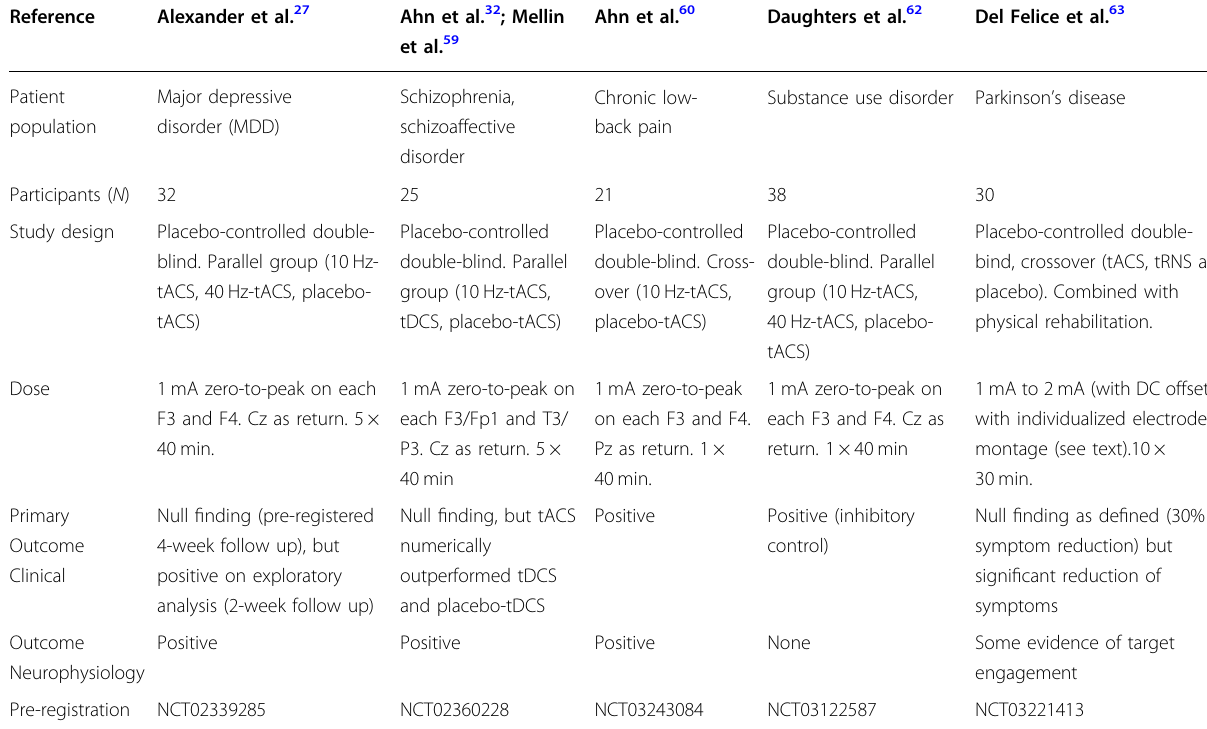
Table 1 Summary of published double-blind placebo-controlled clinical trials of tACS.